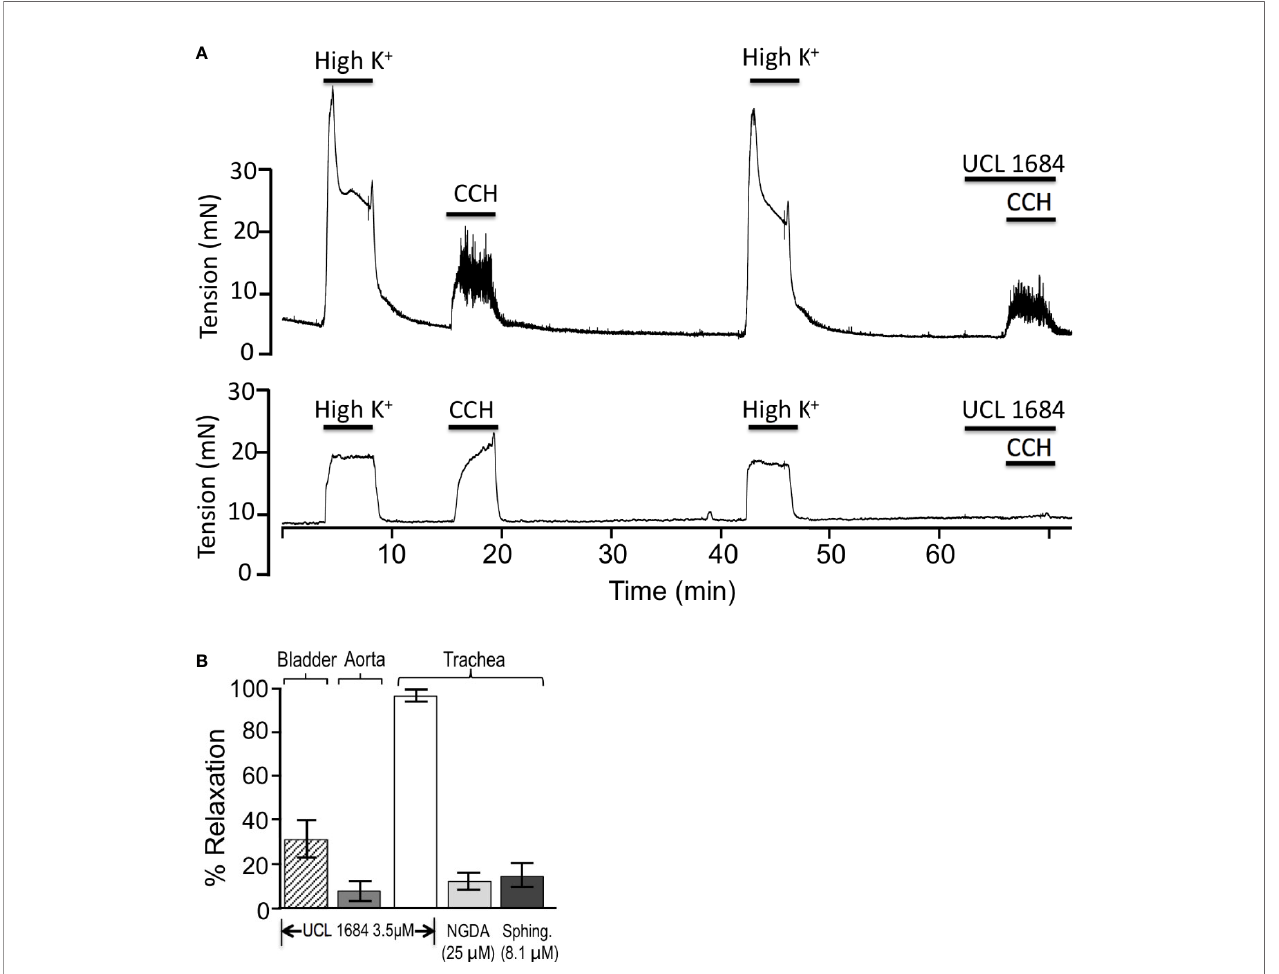
FIGURE 4 | UCL 1684 potently relaxes airway smooth muscle, but has weak effects on bladder and vascular muscle. (A) Sample tracings of bladder (above) and trachea (below) response to 3.5 m M UCL 1684. Shown are repetitive contractile responses to high potassium stimulation (67 mM K + PSS solution) and 0.5 m M carbachol. The second carbachol response was preceded by addition of UCL 1684, which had moderate effects on bladder, but completely prevented trachea contraction response. (B) Summary 3.5 m M UCL 1684 relaxation response (as above) of bladder (diagonal hatch, 31.4 ± 8.4, N=6), aorta precontracted to 300 nM phenylephrine (7.8 ± 4.3, N=3), and trachea (white, 95.4 ± 2.4, N=6). Trachea was also tested for relaxation response to TrpM channel blockers nordihydroguaiaretic acid (NGDA, light gray, 12.4 ± 8.5, N=8), and d-erthyro-sphingosine (Sphing., dark gray, 14.9 ± 6.0,